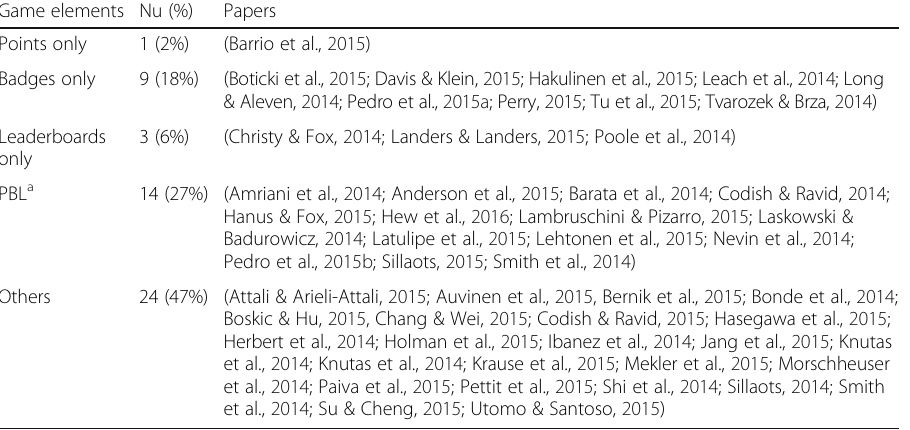
Table 5 Game elements tested in the